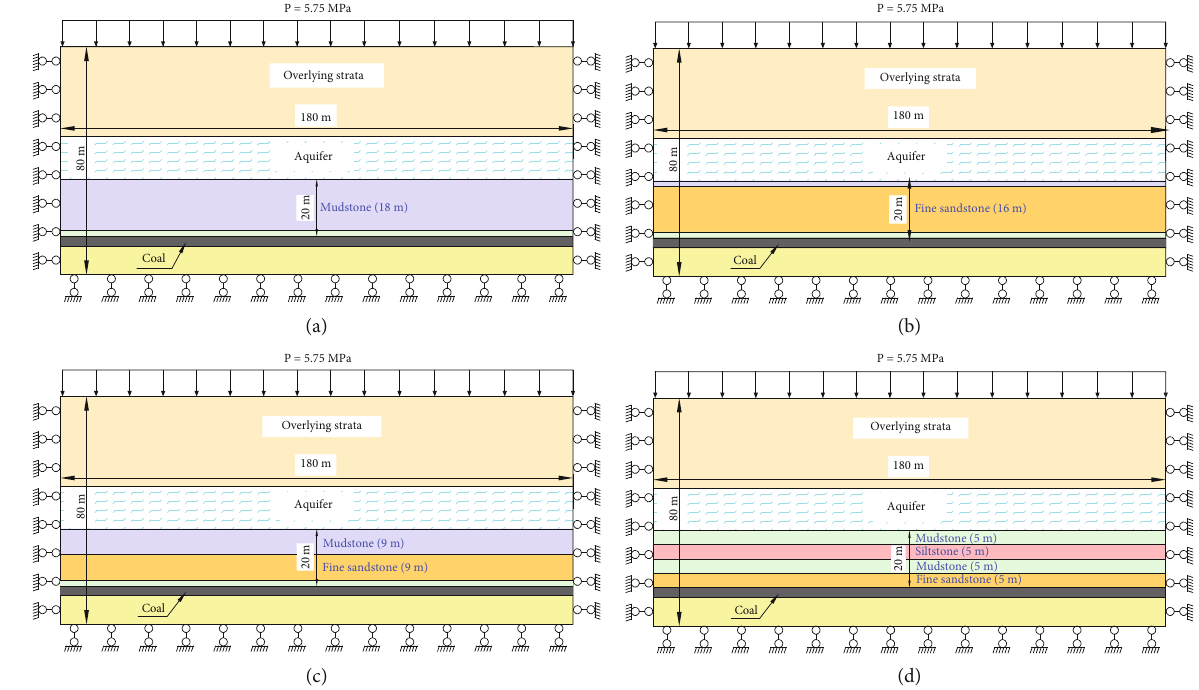
Figure 2: Numerical model with di ff erent interlayer rock thickness: (a) 15 m; (b) 21.8m; (c) 25 m; (d)